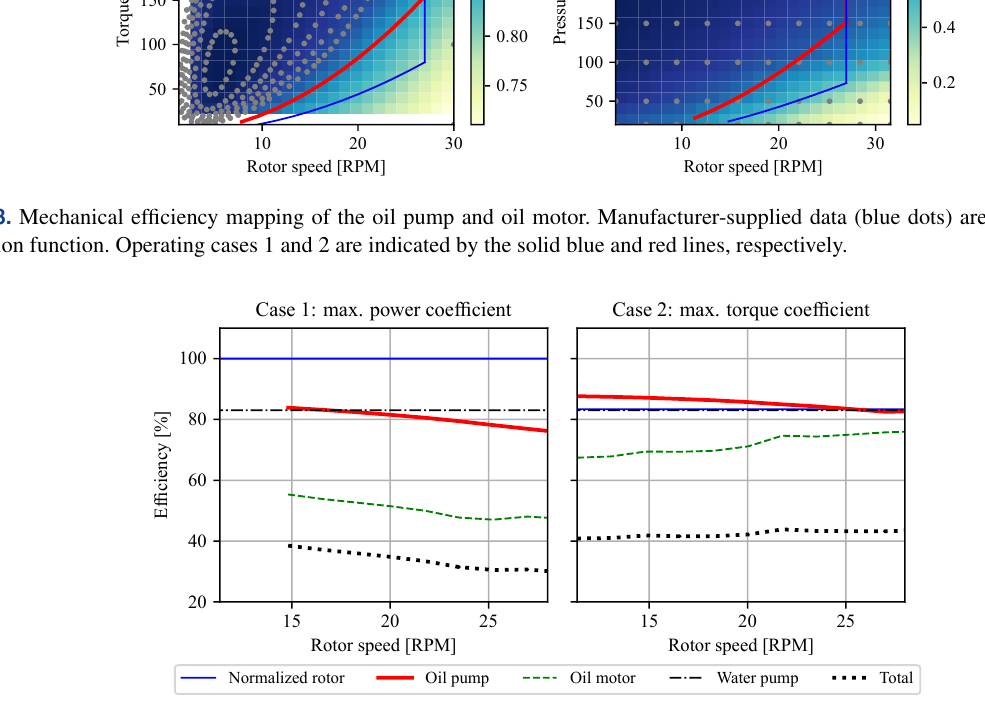
Figure 14. Comparison of the total drivetrain efficiency for operating cases 1 and 2. It is observed that the total efficiency is higher in the complete below-rated region for case 2. The efficiency over all rotor speeds is also more consistent, enabling passive torque control using a constant nozzle area A nz